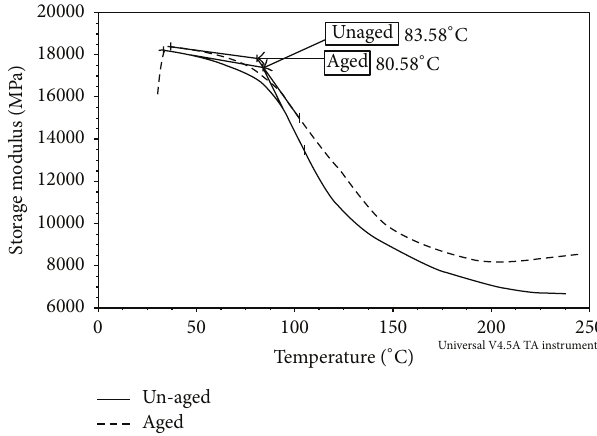
Figure 5: Alteration of tan 𝛿 peak of EHG250-68-37 composite samples a 800 h thermooxidative aging at 82 ∘ C.